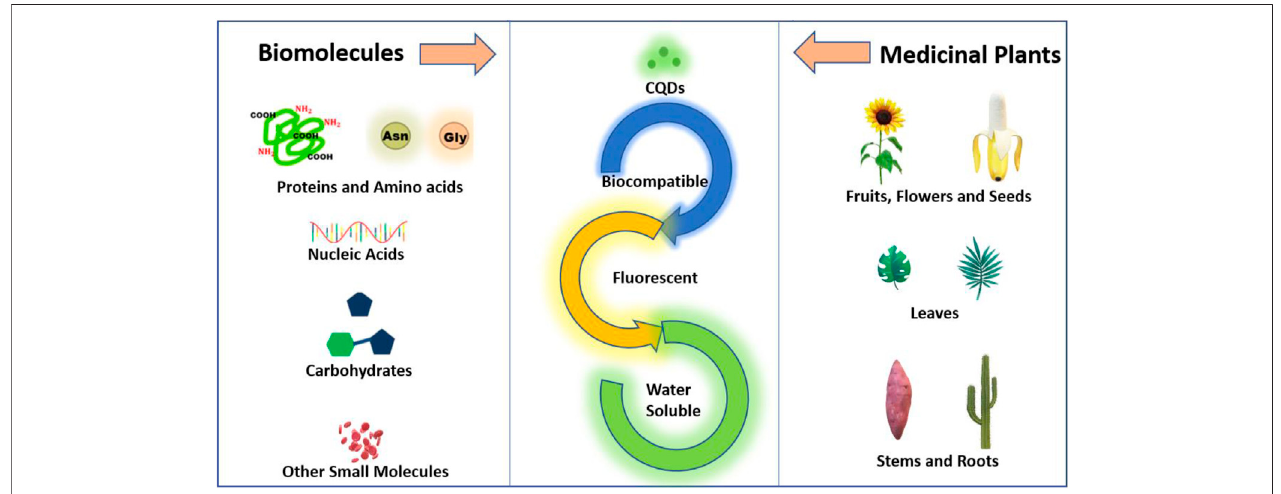
FIGURE 2 | Schematic representation of precursors for the synthesis of CQDs from biomolecules and medicinal